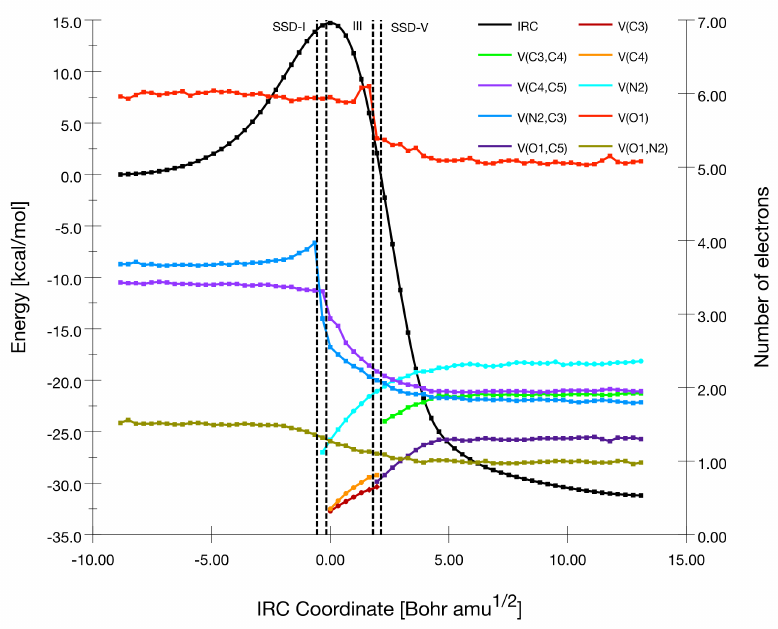
Figure 6. Population evolution (in e) of selected basins along the IRC associated with TS3-a . These two catastrophes illustrate the creation of a pseudo-radical center on C3 [V(C3) with 0.35e] and C4 [V(C4) with 0.32e] carbon atoms, and which will be involved in the formation of the C-C bond. The fourth domain ( d (C3-C4 = 1.941 Å and d (O1-C5) = 1.698 Å)) deals with creation of the V(O1,C5) disynaptic basin, which corresponds to the formation of the O1-C5 bond. Its population comes from the reduction in the population of V(O1), which records a drop of 0.71e. Finally, the fusion of the monosynaptic basins V(C3) and V(C4) happens at the beginning of the fifth domain ( d (C3-C4 = 1.893 Å and d (O1-C5) = 1.653 Å)) with the creation of a new V(C3,C4) corresponding to the formation of C3-C4 bond. The new V(C3,C4) basin takes its population from the disappearance of the two former V(C3) and V(C4) monosynaptic basins present since the third domain. See Scheme 6 for a pictorial description of the electronic flows using curly